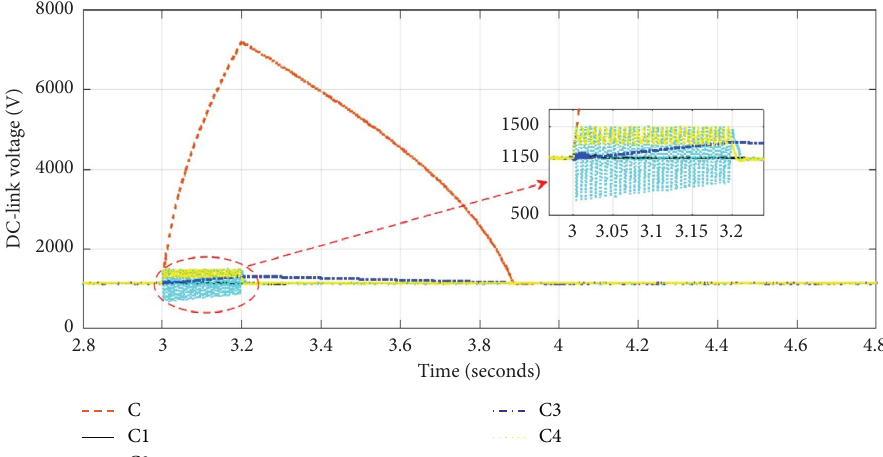
Figure 22: V during 100% voltage dip (worst condition). dc